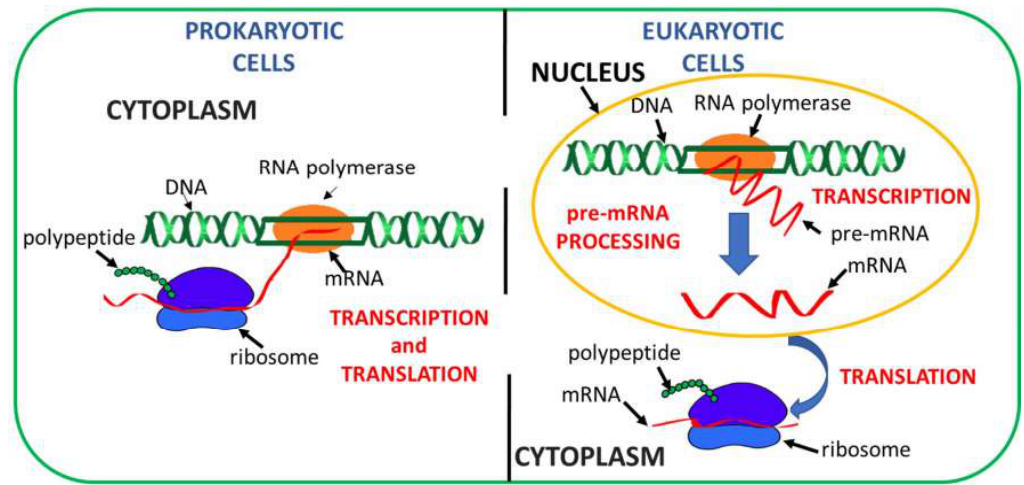
Figure 1. Steps involved in protein synthesis in prokaryotic (left) and eukaryotic cells (right). In this context, mutations are alterations in the DNA sequence that are reflected in the gene transcript and, when nonconservative, can result in the production of nonfunctional proteins or even hinder protein expression. Among all types of mutations, base substitutions (also known as point mutations) are the most common and can belong to the classes of silent, missense, or nonsense mutations [5]. Silent mutations are harmless since they change a codon for a different one that codes for the same amino acid, thus resulting in the production of a protein identical to the wild-type one.